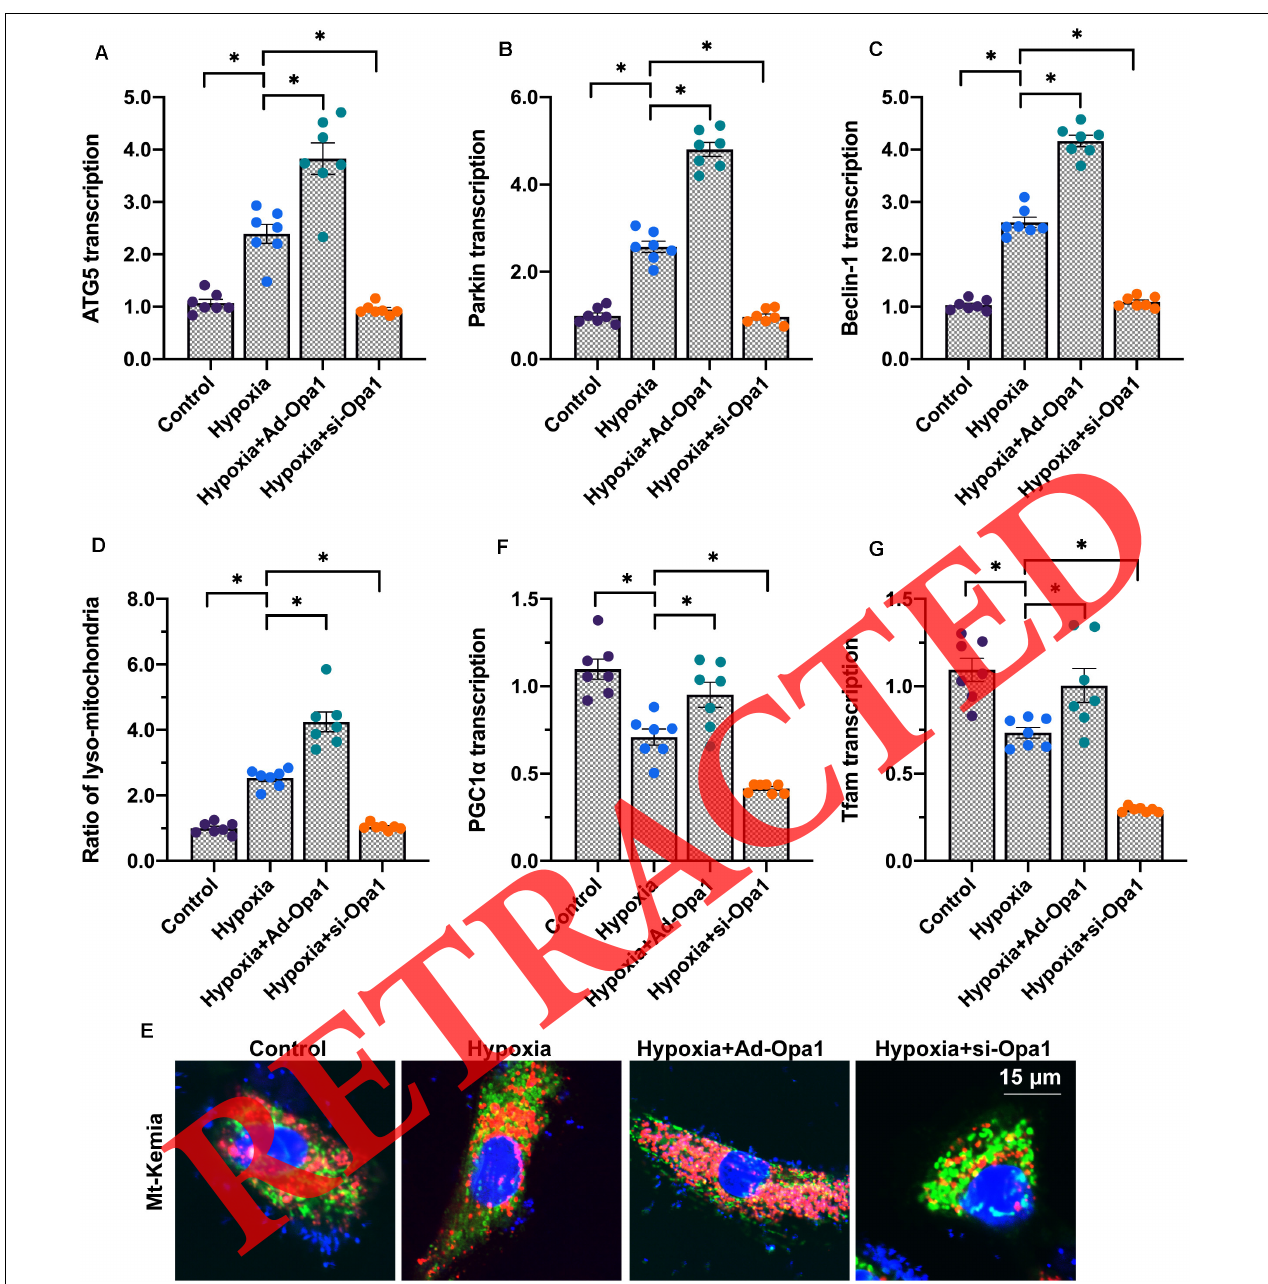
FIGURE 3 | Opa1 activates mitophagy and mitochondrial biogenesis in hypoxia-treated cardiomyocytes. (A–C) Analysis of ATG5, Parkin, and Beclin1 expression through qPCR. (D,E) Mitophagy analysis in living cardiomyocytes by mt-Keima reporter assay. (F,G) Analysis of Tfam and PGC1 α expression through qPCR. ∗ p <